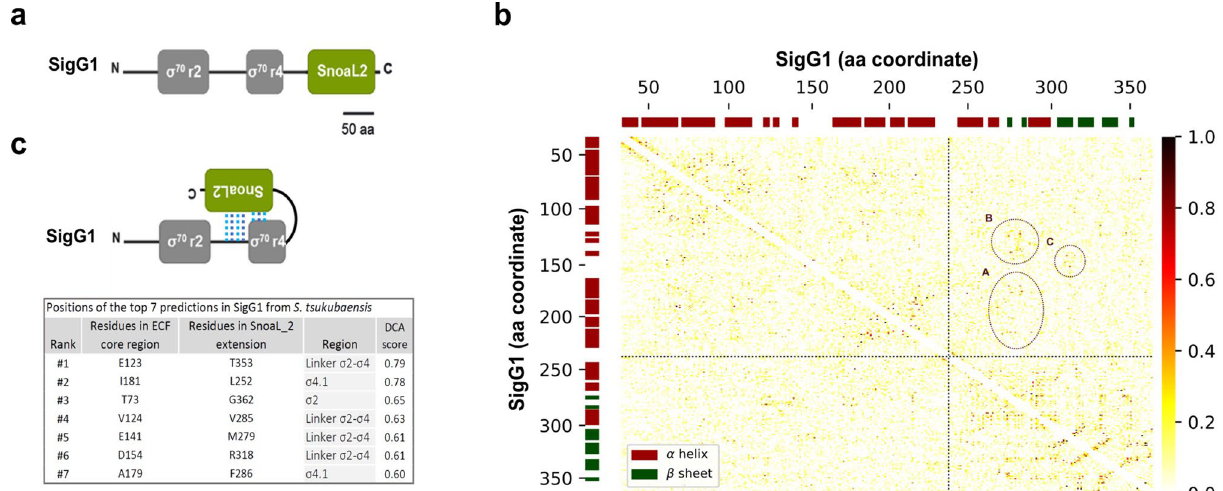
Figure 1. Predicted intramolecular interactions for ECF56. ( a ) Schematic representation of the Pfam domain organisation of the sigG1 encoded protein. SigG1 harbours the σ2 (PF04542) and σ4 (PF04545) conserved domains, and an additional long C-terminal extension, coding for a SnoaL_2 domain (PF12680). ( b ) Contact map for predicted contacts between ECF core regions and the SnoaL_2 extension, using Direct Coupling Analyses (DCA). Each axis corresponds to the amino acids of SigG1 and the heatmap represents the DCA output, where darker spots correspond to higher scores. Scores > 1 are set to 1 in order to allow for the observation of smaller scores. Dashed lines split the core ECF regions from the C-terminal extension. Significant contacts between SnoaL_2 and core ECF regions are indicated by circles. ( c ) Model for compact conformation of SigG1 as predicted by DCA. DCA rank and scores of the significant contacts between ECF core regions and the SnoaL_2 domain are